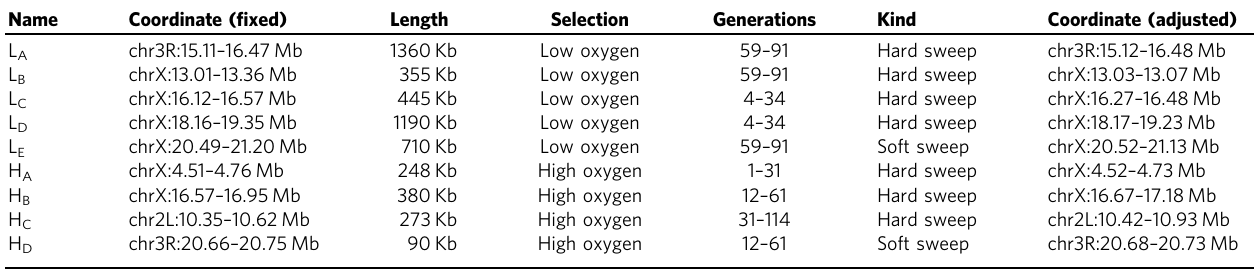
Table 1 Selected intervals that have frequency distribution synchronized in all three biological replicates (replicated sweeps).